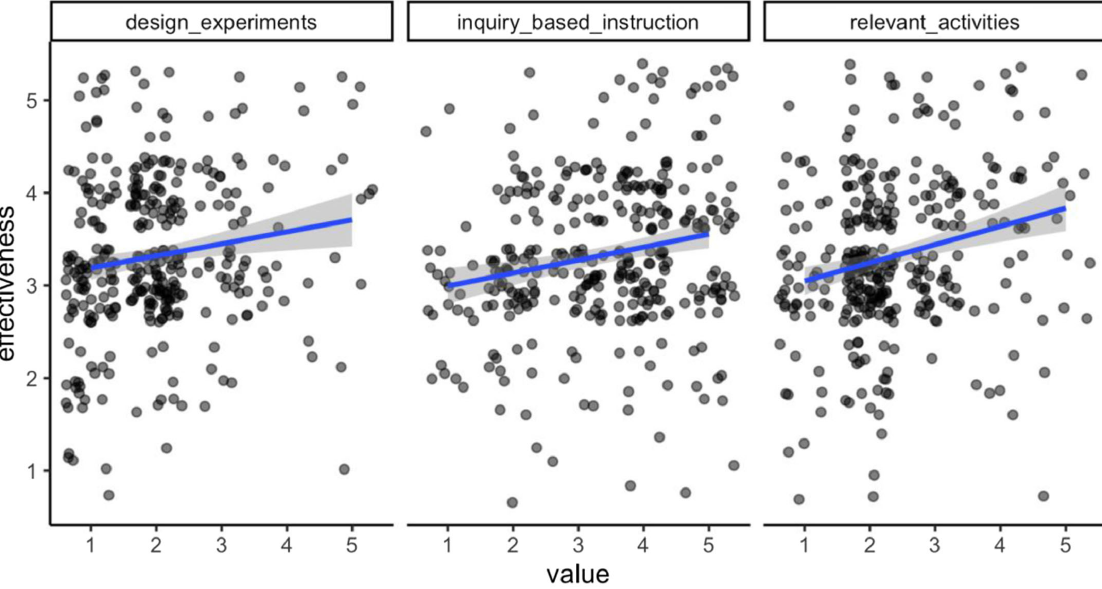
FIG. 3. Associations between laboratory teaching strategies and perceived course effectiveness in engaging